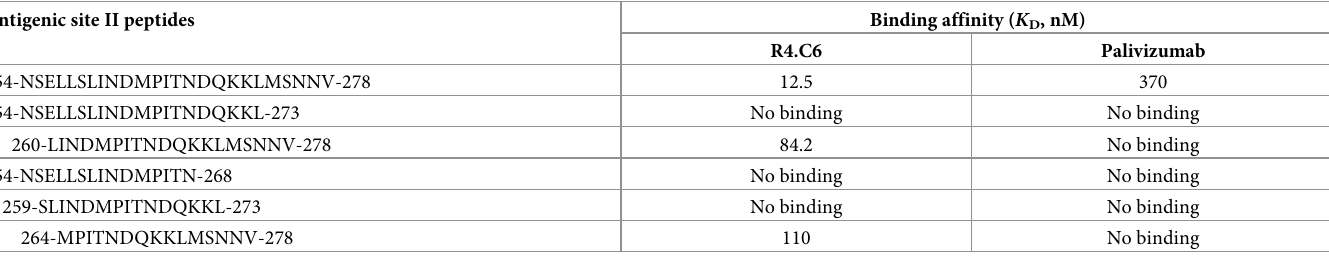
Table 2. Binding of R4.C6 to site II synthetic peptides determined by surface plasmon